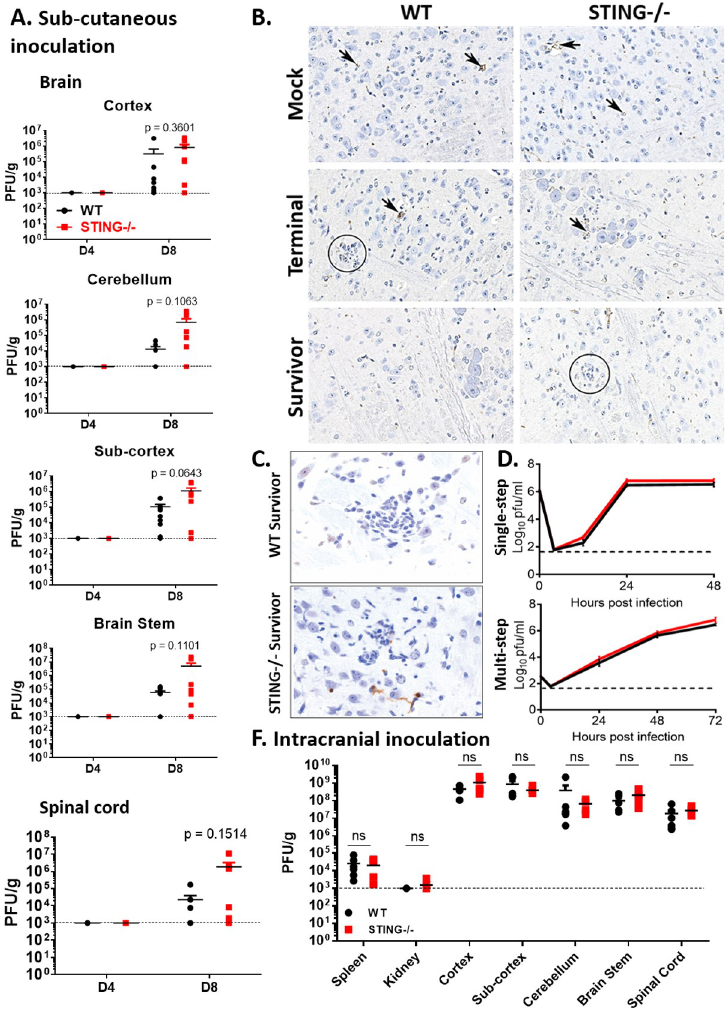
Fig 2. STING is not required for viral control of WNV in neurons in vitro or in the CNS during intracranial infection in vivo . (A) WNV viral load in macro-dissected brain sections (cortex, sub-cortex, cerebellum and brain- stem) and spinal cord of WT and STING-/- infected mice, D4 and D8 post infection. n = 6–10 per strain per time- point. Graphed as stacking points. Limit of detection indicated by dashed line. Unpaired students t-test; p = 0.05 � ; p = 0.005 �� . (B) WNV IHC in the brains of mock infected and WNV infected WT and STING-/- Terminal and Survivor cohort. Mock tissues are unremarkable with non-specific staining of capillaries (arrows). Terminal mice have punctate staining near foci of gliosis (WT, circle) or neuronal degeneration (WT and STING-/-, arrows). No discernable specific signal for WNV antigen was observed in either WT or STING-/- Survivors, despite observable gliosis in STING-/- (circle). All panels, original magnification 200X. (C) TUNEL IHC stains of representative WT and STING-/- Survivor (18 dpi) mice. Brown stain indicates neuronal death. (D). Single and multistep virologic analysis of primary cortical neurons from WT and STING-/- mice. Pooled samples of 3 embryos per genotype. (E) Titer in mice infected with WNV via intracranial inoculation D4 pi. n = 6 WT and n = 5–6 STING-/-. Students t-test, p = 0.05 � ; p = 0.005 ��